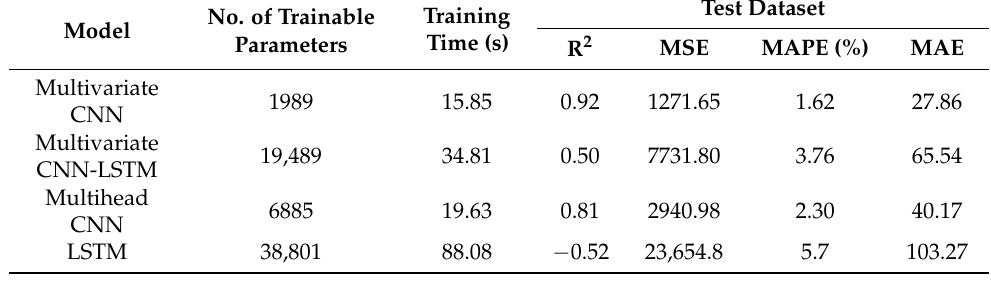
Table 12. Comparison of CNNs and LSTM in terms of training time and performance measures.